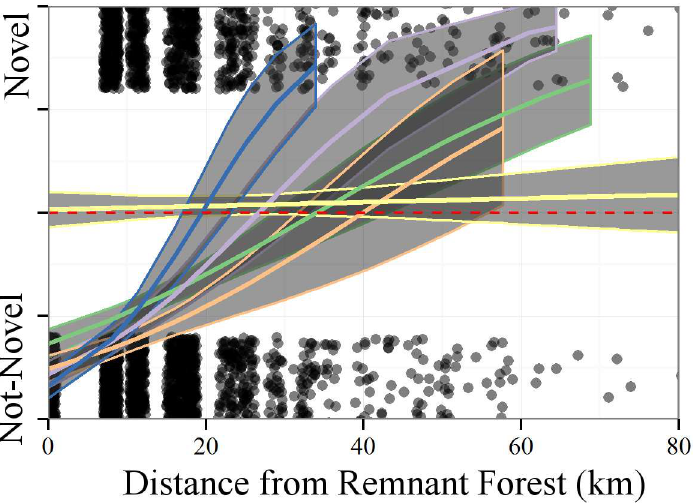
Fig 9. The model relating the probability of novel forests to spatial distance from remnant forest. Here the 25%ileis used to indicateremnant forest, and the 95%ileis definedas novelty. Binomialregression predicts the probabilityof novel forest, the red dashed line indicatesa responsegreater than 0.5. The curves representthe relationshipbetweenspatialdistance and dissimilarity for each of the five major historic forest types (Fig 5) definedhere as Oak Savanna(blue), Oak-Poplar-Basswood-Maple (light purple), Tamarack- Pine-Spruce-Poplar(green), Hemlock-Cedar-Birch-Maple (yellow)and Pine (orange). Points are jittered to improvedisplay. Points at 1 are cells whose dissimilarity is greater than the 95th %ile of dissimilarities within the PLSS, here considered novel forest.